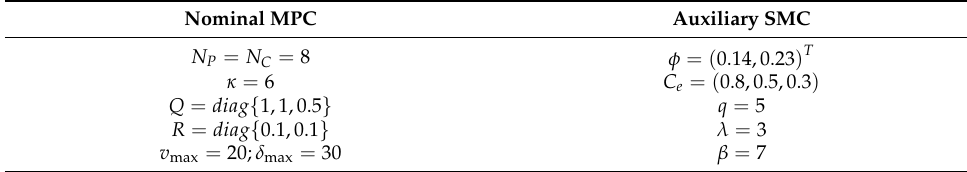
Table 5. SMC-based tube MPC.